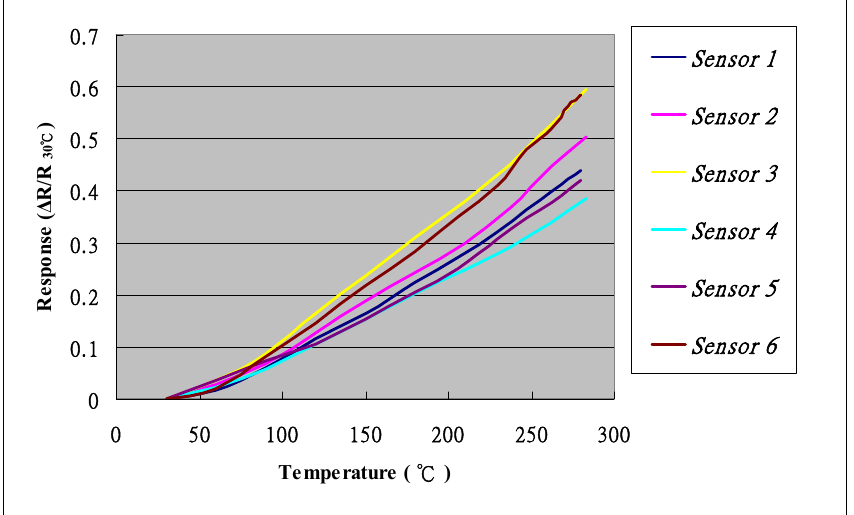
Figure 5. Calibration curves of micro temperature